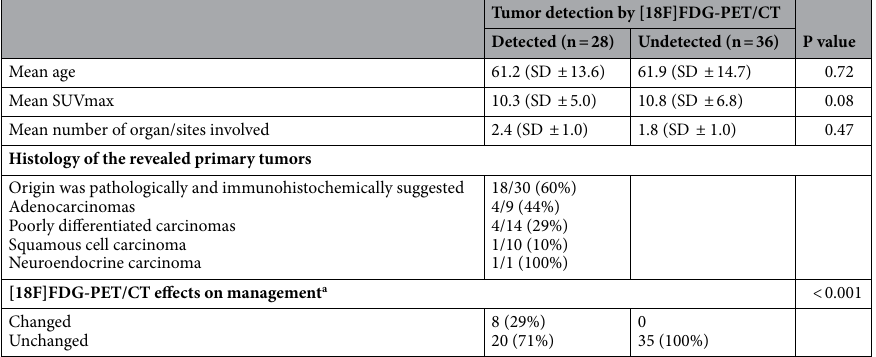
Table 2. Characteristics of patients with cancer of unknown primary site according to [18F]FDG-PET/CT detection of the primary site. a The number of patients with management data is 63, one patient with squamous cell carcinoma and an undetected primary site was lost to